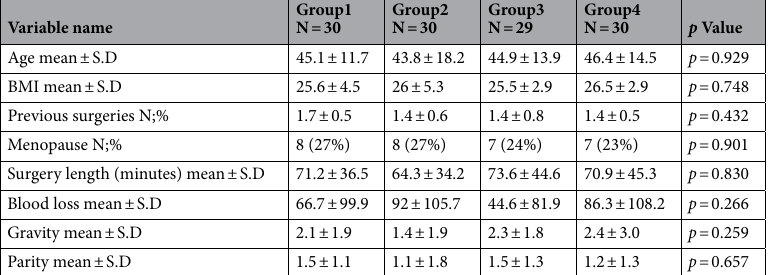
Table 1. Comparison of women and surgery characteristics between the study groups. Group 1— Subcutaneous drug and intraperitoneal drug. Group 2—Subcutaneous drug and intraperitoneal placebo. Group 3—Subcutaneous placebo and intraperitoneal drug. Group 4—Subcutaneous placebo and intraperitoneal